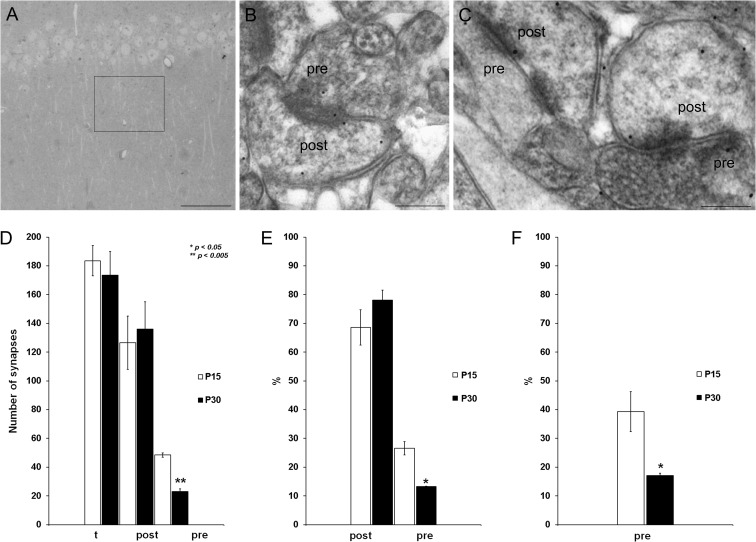
Presynaptic NR1 is downregulated during development. (A) Transmitted light photomicrograph illustrating the CA1 area of the mouse hippocampus analyzed (square). (B, C) Electron photomicrographs of the CA1 demonstrating the presence of NR1 immunolabeling (arrows) at both presynaptic (pre) and postsynaptic (post) sites at P15 (B) and P30 (C). Scale bars: 200 μm (A) and 200 nm (B, C). (D) The number of NR1 immunolabeled postsynaptic sites did not change from P15 to P30, whereas the number of immunolabeled presynaptic terminals decreased significantly at P30 compared with P15. (E) The proportion of presynaptic labeled terminals relative to the total number of synapses decreases with age, while the percentage of labeled postsynaptic terminals does not change significantly. (F) A statistically significant decrease was also observed when the proportion of presynaptic labeled terminals was compared with the number of NR1 labeled postsynaptic terminals: t, total number of synapses counted, n = 4 mice (2 for each age analyzed). The error bars represent the S.E.M., and >150 synapses per mouse and region were analyzed: *P < 0.05; **P < 0.01, unpaired Student’s t-test.